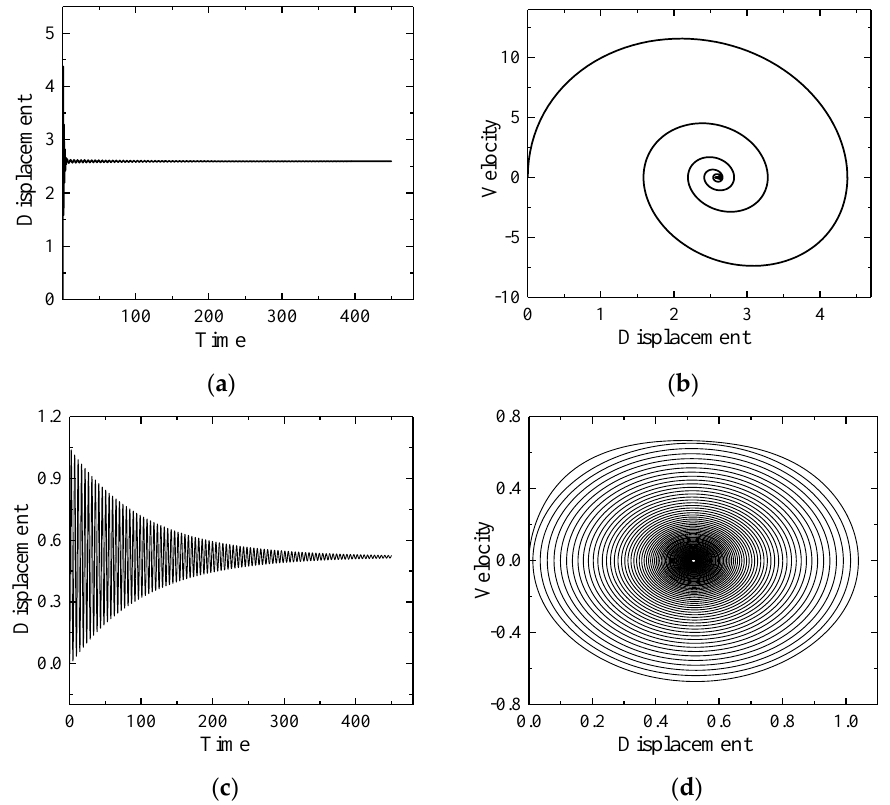
Figure 22. Evolutions of the displacement and speed-displacement diagram of brake disc and brake shoe at the sti ff ness of k 1 = 1 N / m and k 2 = 5 N / m. ( a ) Evolution of the displacement of the brake shoe. ( b ) Evolution of the speed-displacement diagram of the brake shoe. ( c ) Evolution of the displacement of the brake disc. ( d ) Evolution of the speed-displacement diagram of the brake disc.